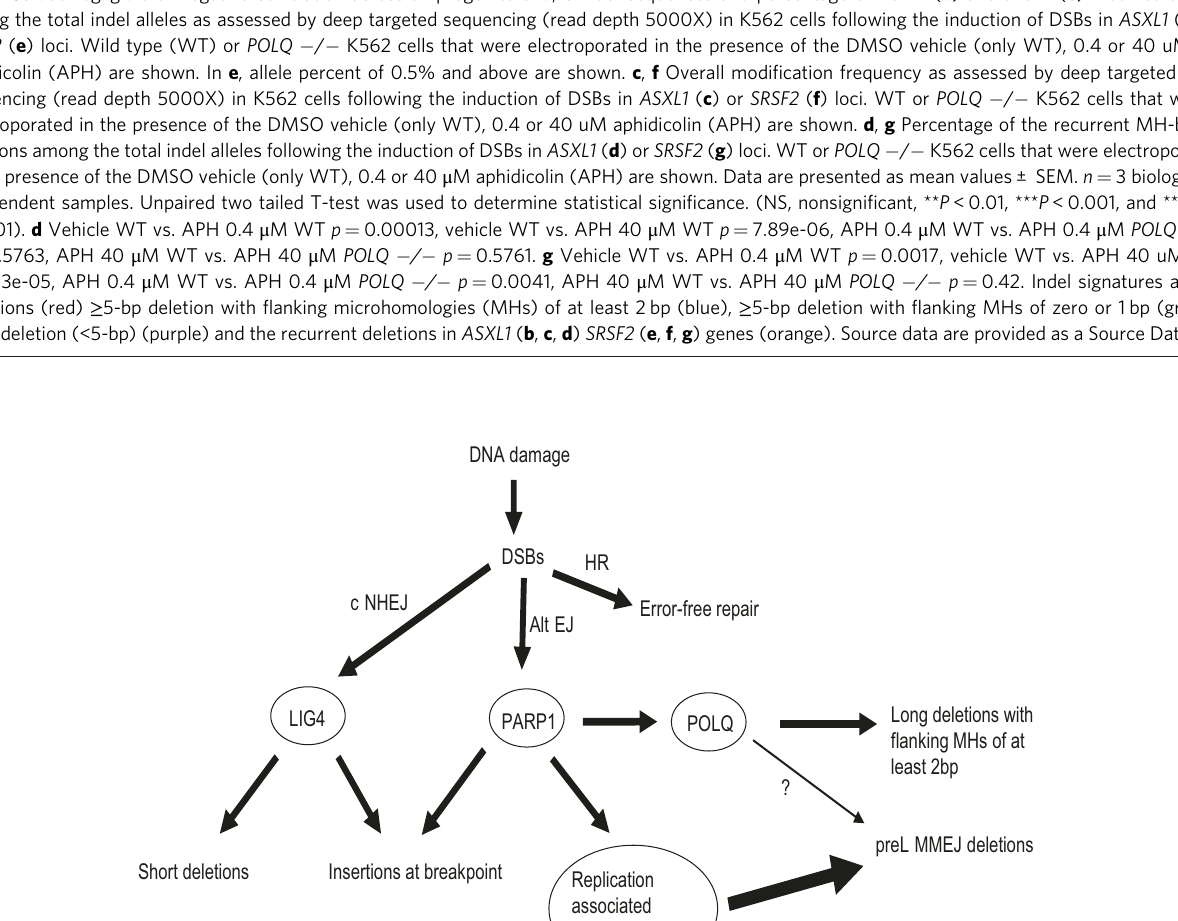
Fig. 7 Aphidicolin treatment reduces the formation of preL-MMEJ deletions. a Scatter plot of Pearson correlations between PARP1 and various DNA polymerase genes normalized expression, compared when calculated for all the progenitors metacells in the bone-marrow CD34 + data (X-axis) and speci fi cally for hematopoietic stem and progenitor cells (HSPCs) metacells (Y-axis). Red gene names show DNA polymerases with signi fi cant correlation in HSPCs but negligible or negative correlation across all progenitors. b , e Indel sequences and percentage of ASXL1 ( b ) and SRSF2 ( e ) modi fi ed alleles among the total indel alleles as assessed by deep targeted sequencing (read depth 5000X) in K562 cells following the induction of DSBs in ASXL1 ( b ) or SRSF2 ( e ) loci. Wild type (WT) or POLQ − / − K562 cells that were electroporated in the presence of the DMSO vehicle (only WT), 0.4 or 40 uM aphidicolin (APH) are shown. In e , allele percent of 0.5% and above are shown. c , f Overall modi fi cation frequency as assessed by deep targeted sequencing (read depth 5000X) in K562 cells following the induction of DSBs in ASXL1 ( c ) or SRSF2 ( f ) loci. WT or POLQ − / − K562 cells that were